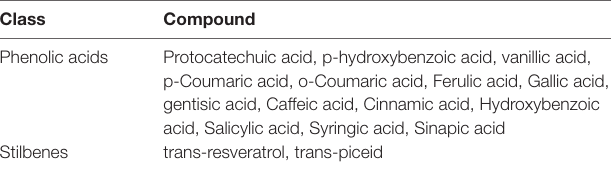
TABLE 2 | Reported non-flavonoid in sorghum (Vanamala et al.,